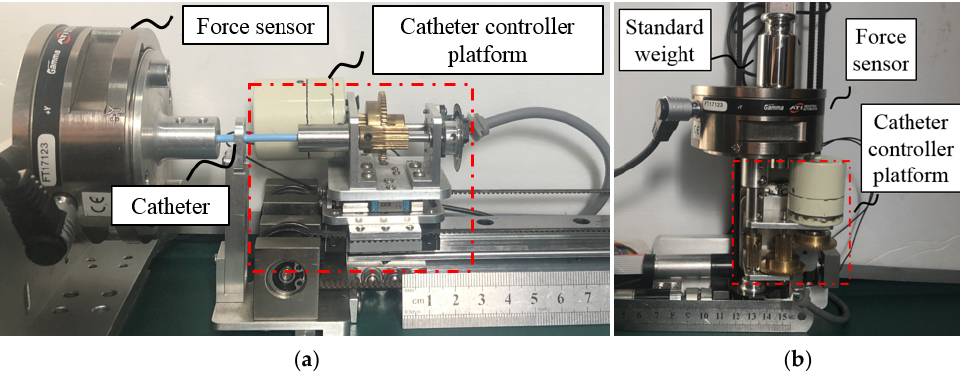
Figure 8. Force feedback accuracy regulation and evaluation. ( a ) Eccentric force compensation and passive force feedback evaluation setup. ( b ) Eccentric force compensation accuracy evaluation setup.